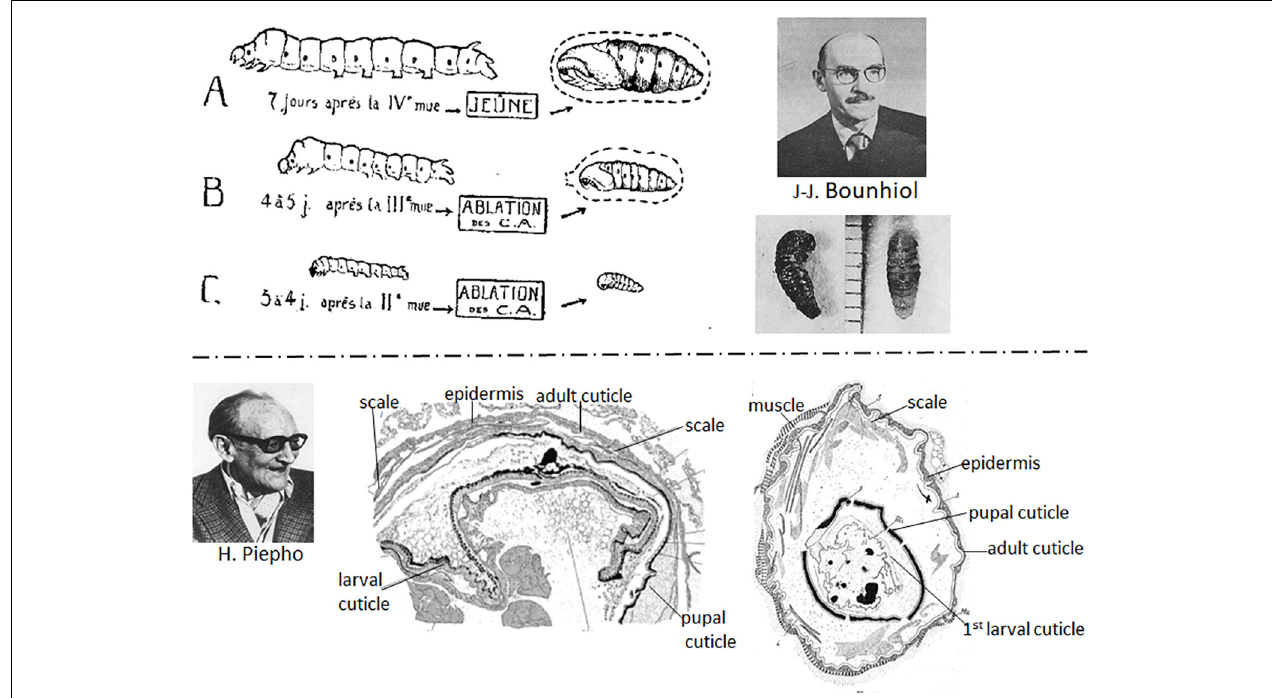
FIGURE 3 | Top : (Left) Diagram of effects of removal of the corpora allata (CA) (allatectomy) from the silkworm Bombyx mori . (A) Normal 5th instar larva and pupa; (B) allatectomized 4th instar larva formed a precocious pupa; (C) allatectomized 3rd instar larva formed a precocious pupa (figure from Bounhiol, 1938). (Right) Jean-Jacques Bounhiol (above); photo of pupae formed from allatectomized 4th (left) and 3rd (right) instar larvae (from Bounhiol, 1938) (bottom). Bottom : (Left) Hans Piepho. (Center) Result of an implant of 5th instar Galleria integument (epidermis plus cuticle) into another 5th instar Galleria larva that subsequently metamorphosed to a pupa and an adult. The implanted epidermis formed a pupal cuticle, then an adult cuticle with scales (from Piepho, 1938a). (Right) Result of an implant of 1 st instar integument into a 5th instar larva after metamorphosis of the host. The implant formed a pupal, then an adult cuticle (from Piepho, 1938b). Photo of Bounhiol from Lamy and Delsol (1980) (reproduced with permission from Elsevier Masson) and that of Piepho from Hintze-Podufal (1996) (reproduced with permission from www.schweizerbart.de/journals/entomologia).